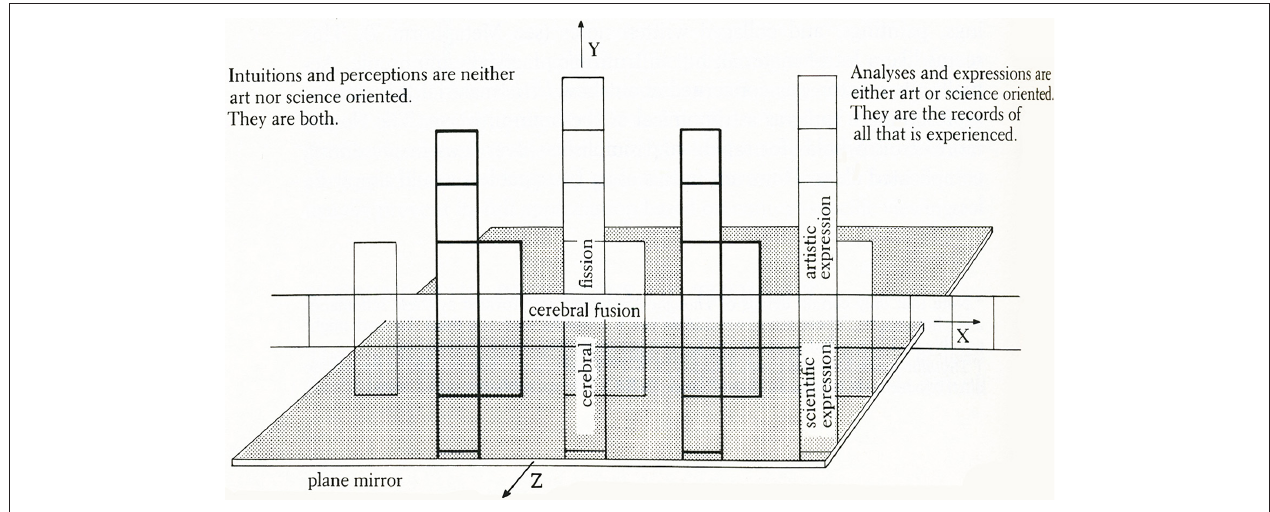
quantifying information is added, entering the realm of science. Thought-Assemblies indicates that analytic and artistic thought can proceed from the same frame of insight-perception and that these two models of thought converge. As an exercise in topology, if the artwork were folded to form a tube and then the ends of the tube were brought together to form a torus, or donut-shape, the farthest points at both ends of the X- and Y-axes would be